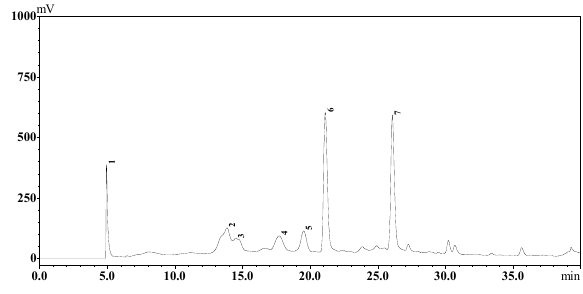
Figure 1. HPLC chromatogram pofiles of major procyanidins of litchi pericarp.